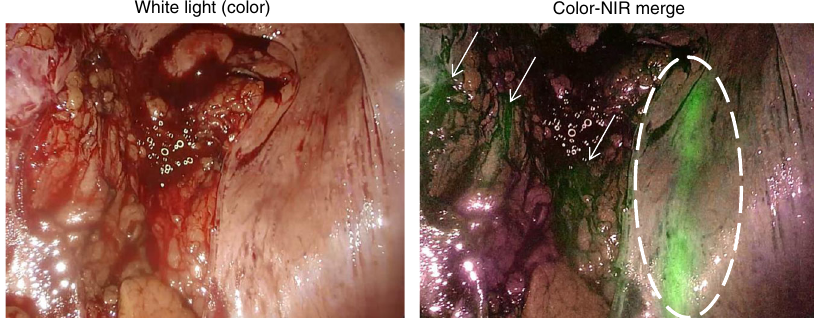
Fig. 2 Ureter residing under peritoneum. The ureter (dashed circle) is captured during a pulse of urine fl ow during surgery. The darker green areas in the near-infrared (NIR) fl uorescence image (small arrows) is background fl uorescence caused by the vessels in the surrounding tissue. The images were acquired using the Olympus ® imaging system during laparoscopic surgery